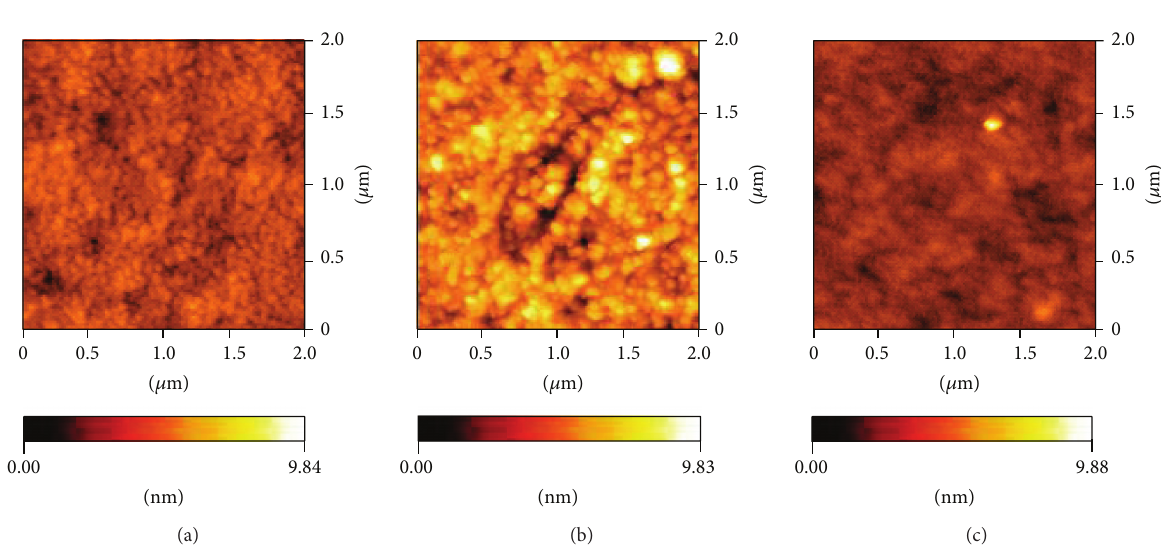
Figure 5: AFM images of the PTB7 thin films prepared with (a) pristine CB, (b) CB and additive of DIO (3v%), and (c) CB and additive of CN (3v%).